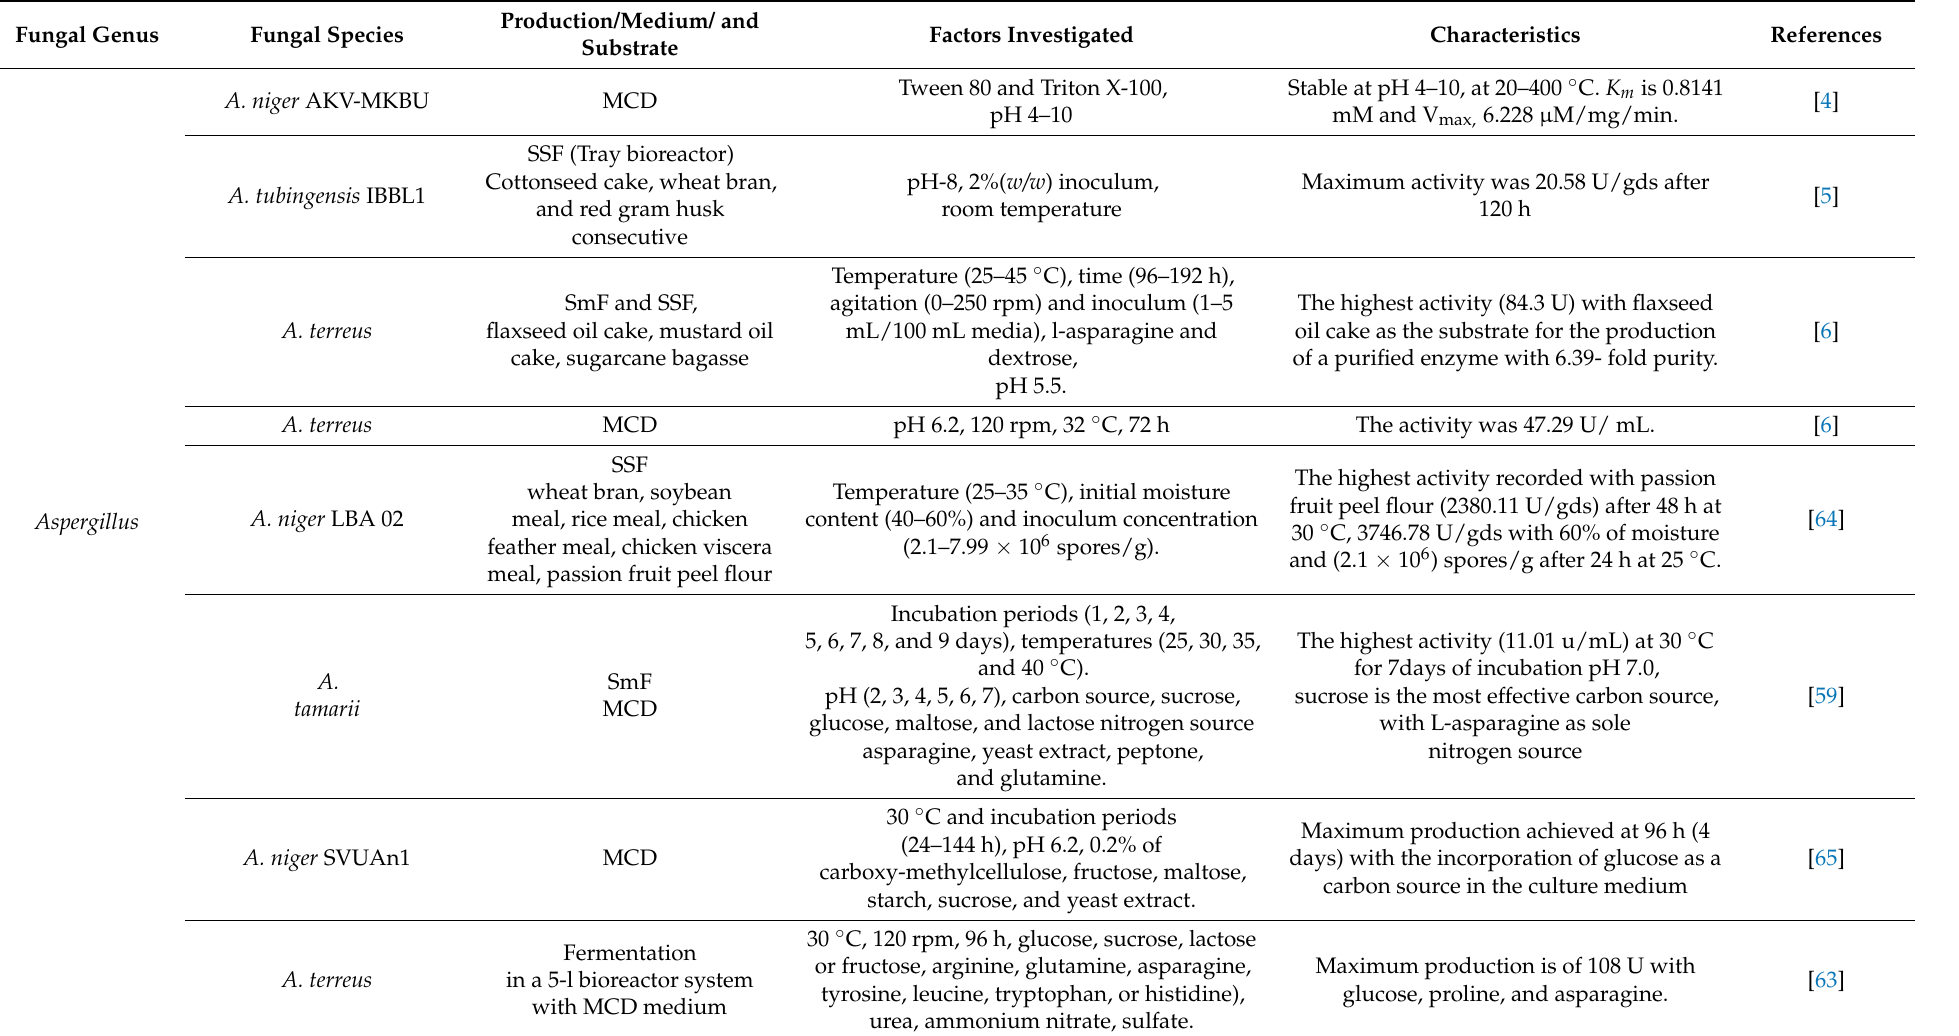
Table 6. Experimental conditions for producing L-asparaginase from different fungal